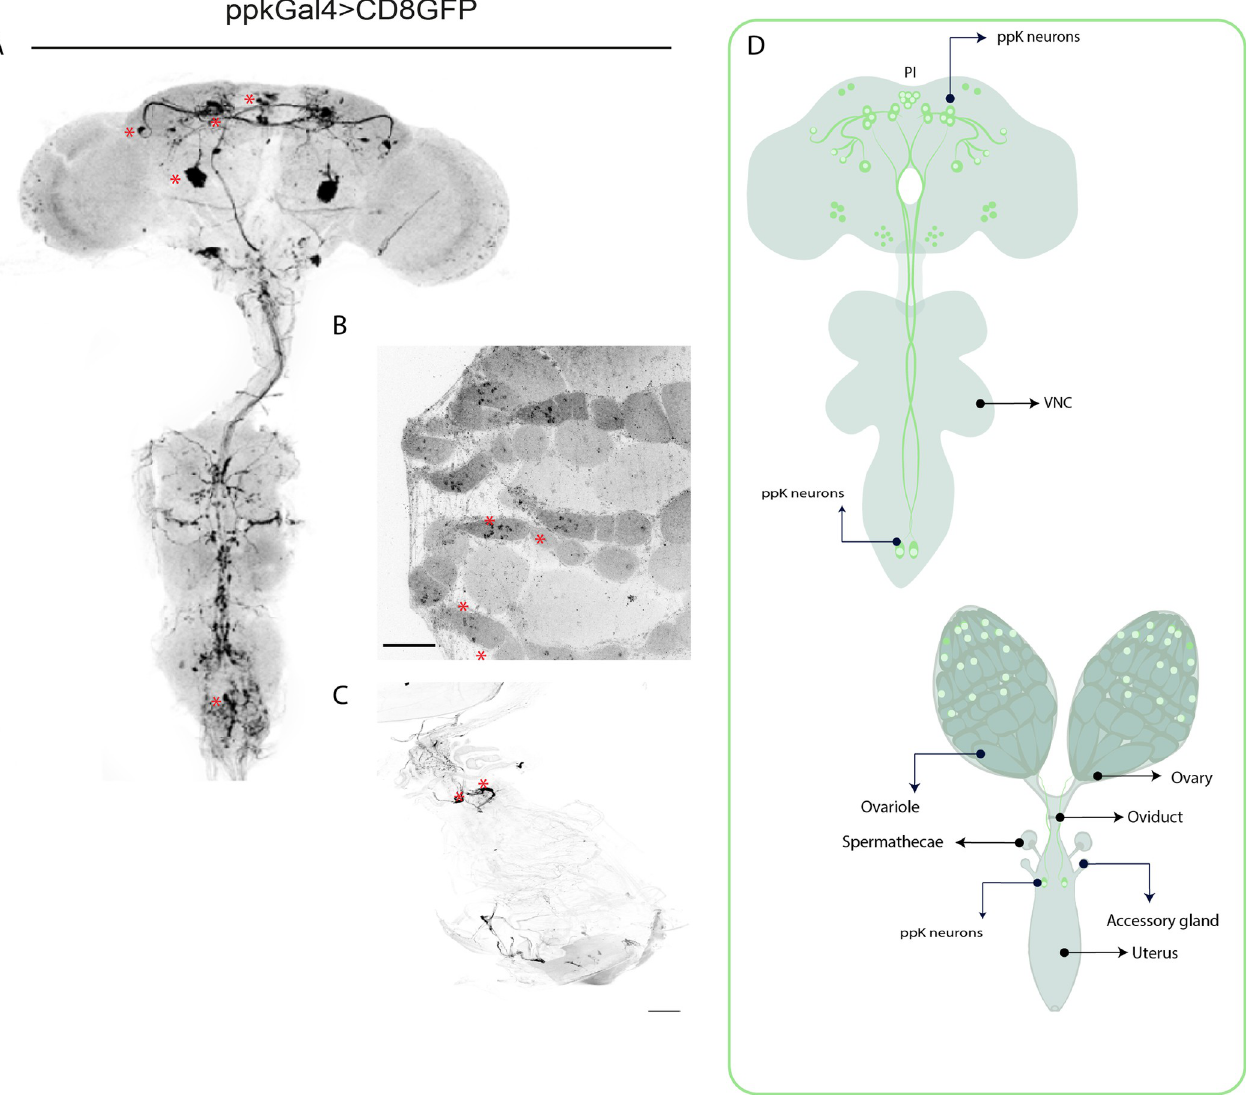
Fig 3. Expression pattern of the ppk -Gal4 line used in this work. ( A , B , C) Confocal immunostaining of a representative brain and ventral nerve cord ( A ), ovaries ( B ) and uterus ( C ) of ppk -Gal4 > UASmCD8GFP females stained with anti-GFP (green). Asterisks indicate the positions of stained ppk + somas. Scale bar 100 μ m for ovaries and 10 μ m for the uterus. (D) Schematic diagram showing the location of ppk + neurons.